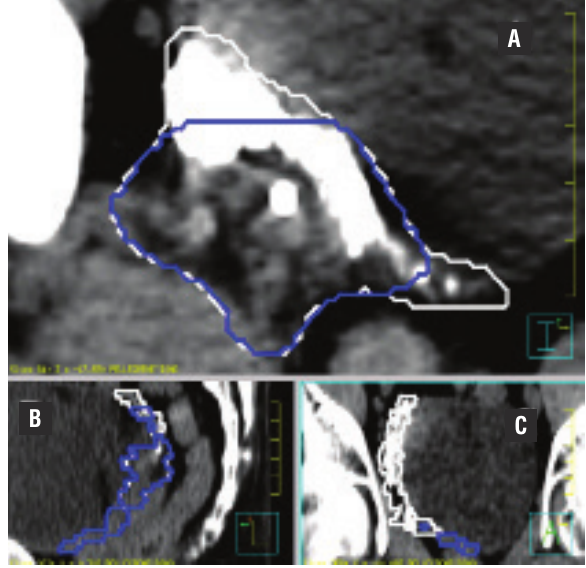
Table 3 - Mean percent volume overlap of CTV Patient